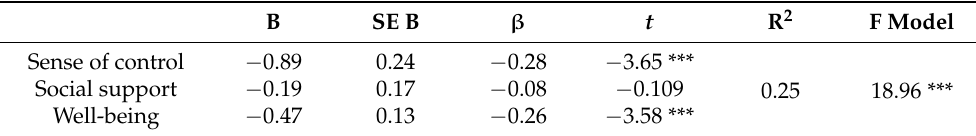
Table 5. Multivariate regression analysis for prediction of long-term symptoms (N = 170).